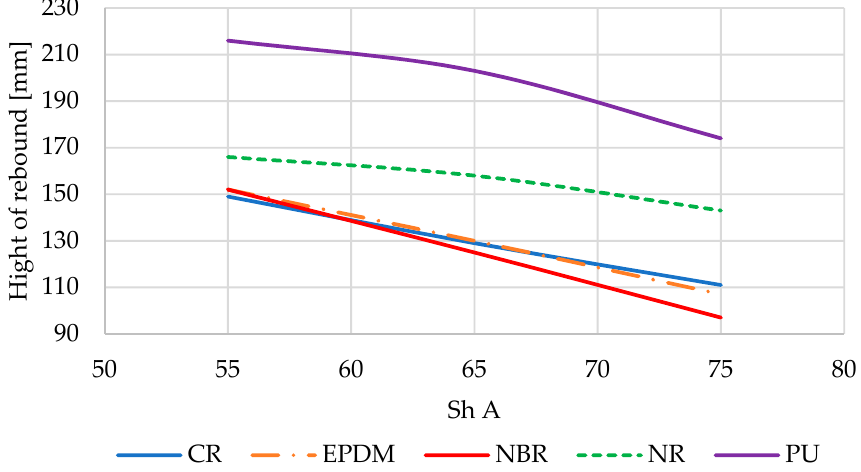
Figure 8. Hight of rebound of all tested shock absorbers dropped from 0.3 m.